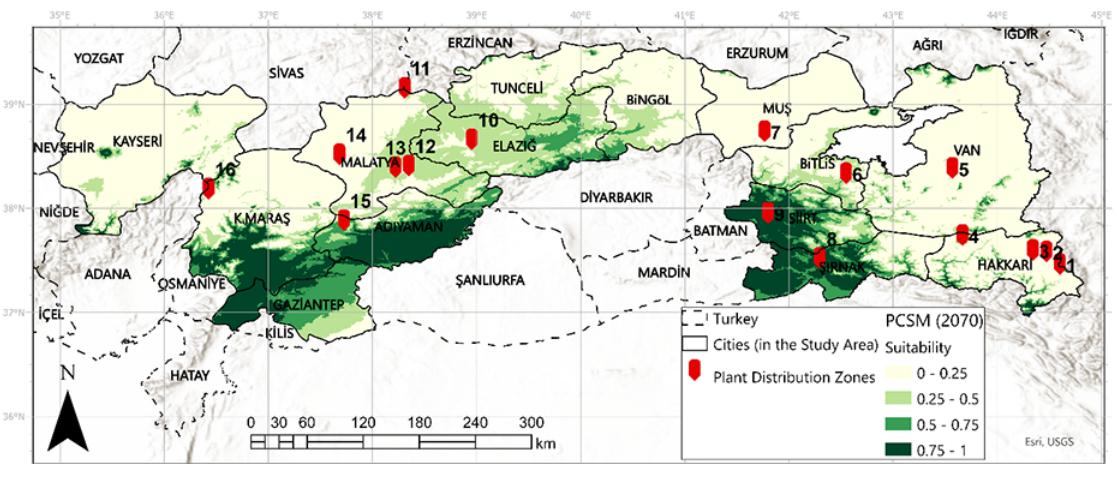
Figure 5 Climatic suitability of Fritillaria imperialis for future conditions (HADGEM2-ES RCP 8.5 outputs – 2070 as an average for 2061–2080).